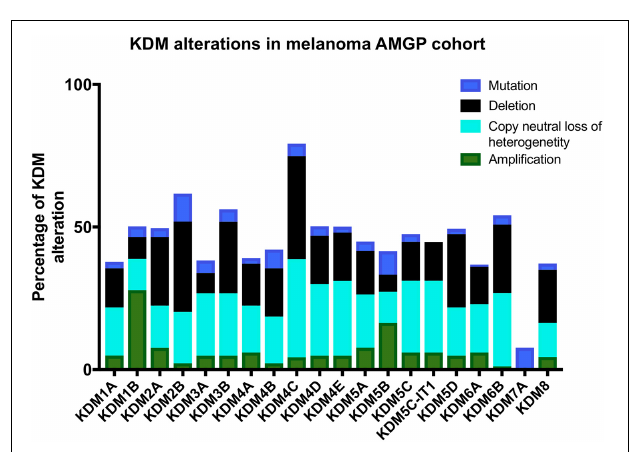
FIGURE 4 | Bar graph showing the percentage of each and type of KDM alterations in 183 melanoma patients from the Australian melanoma genome project